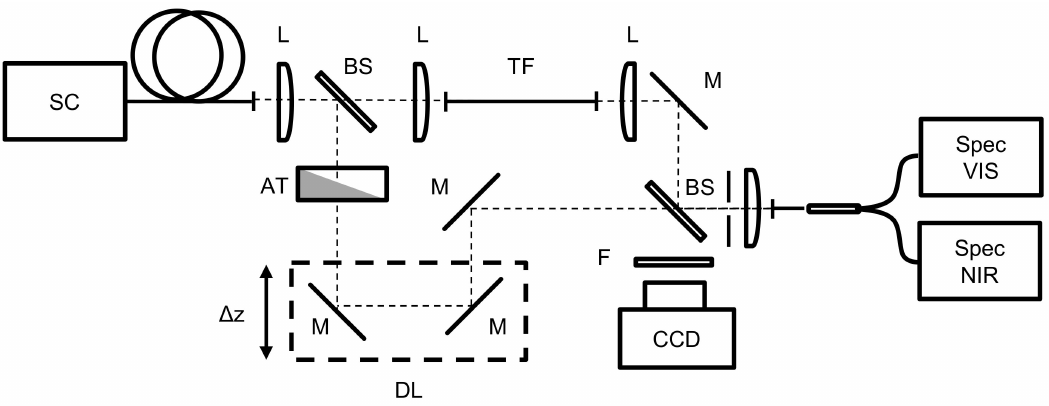
Figure 1. The interferometric setup used for measuring the group-velocity dispersion (GVD), similar to that used in Ref. [12]. SC, supercontinuum light source; BS, nonpolarizing beam splitter; DL, delay line; M, mirror; TF, test fiber; AT, attenuator; F, bandpass filter; L, lens; CCD, camera; and Spec,